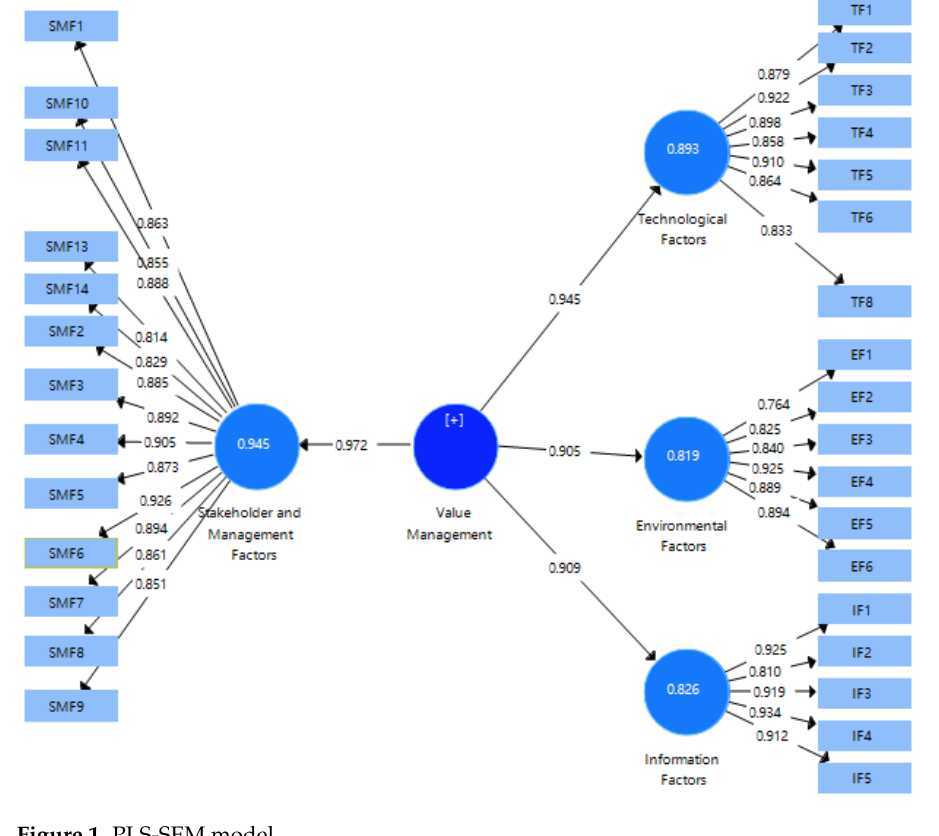
Figure 1. PLS-SEM model.